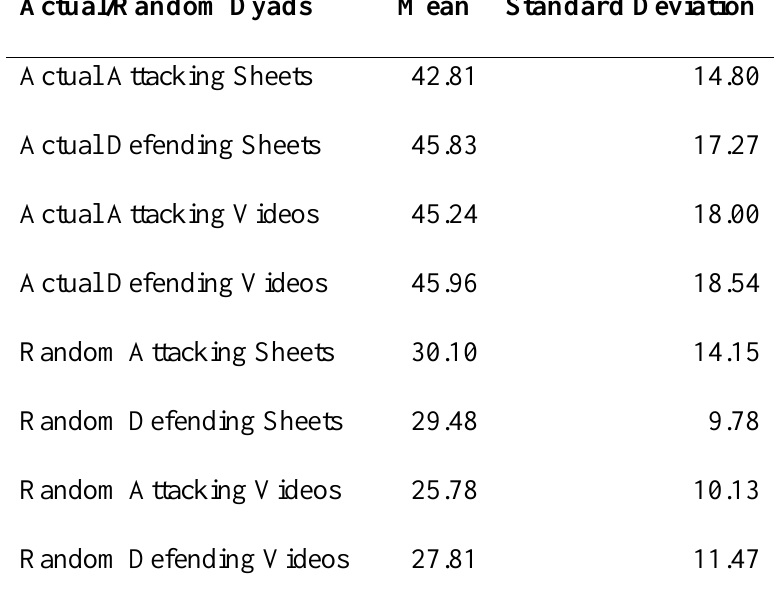
Table 2.1 – Mean and standard deviation values for Actual and Random